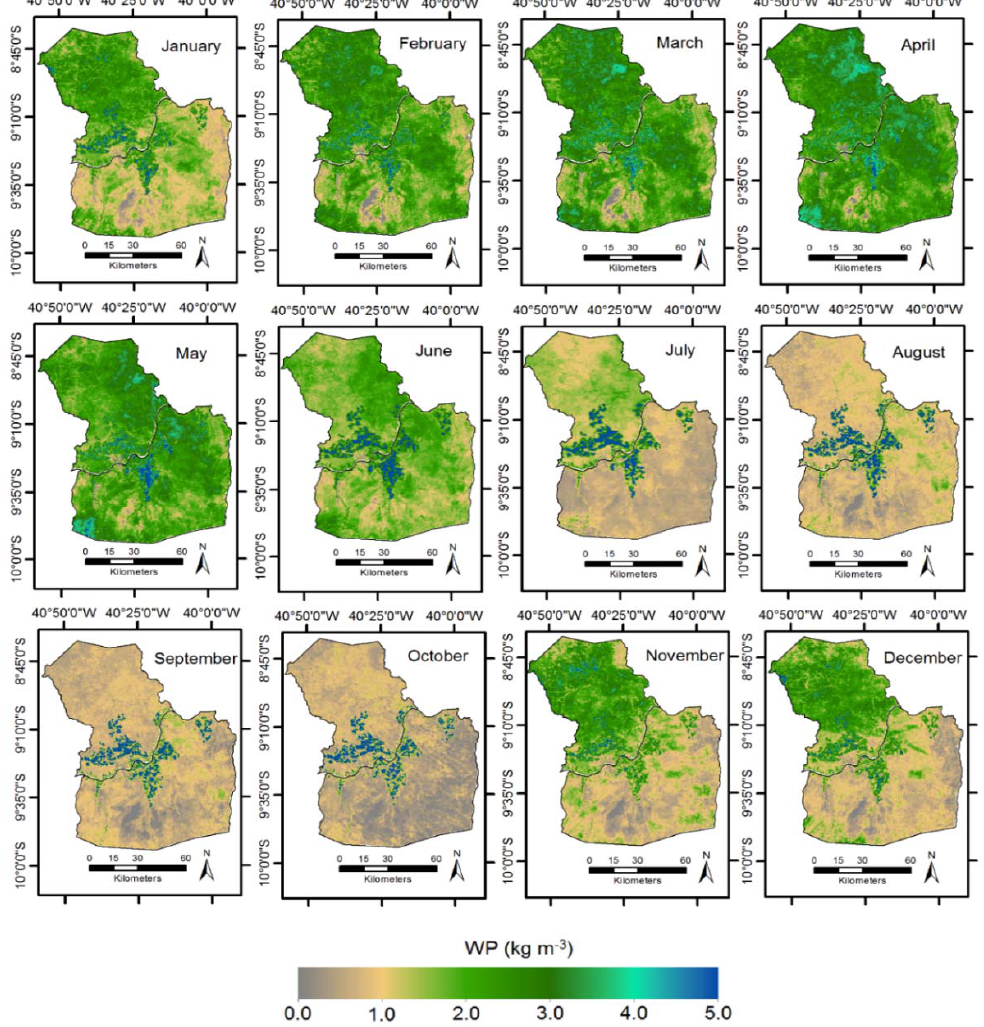
Figure 7. Spatial distribution of the monthly values of water productivity (WP) for the mixed agro-ecosystems, of Petrolina and Juazeiro municipalities, respectively Pernambuco (PE) and Bahia (BA) states, Brazil, during the year of